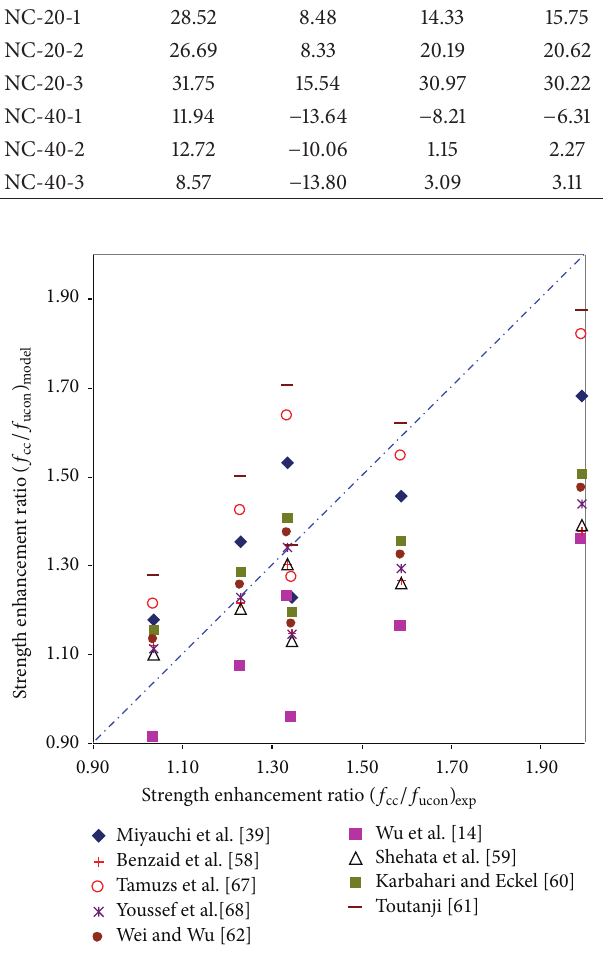
Figure 22: Correlation between theoretical strength enhancement ratio using various existing models and experimental strength enhancement ratio.